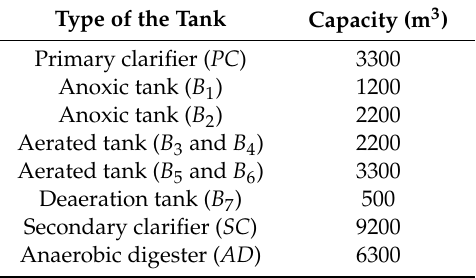
Table 1. The tank capacities of a wastewater treatment